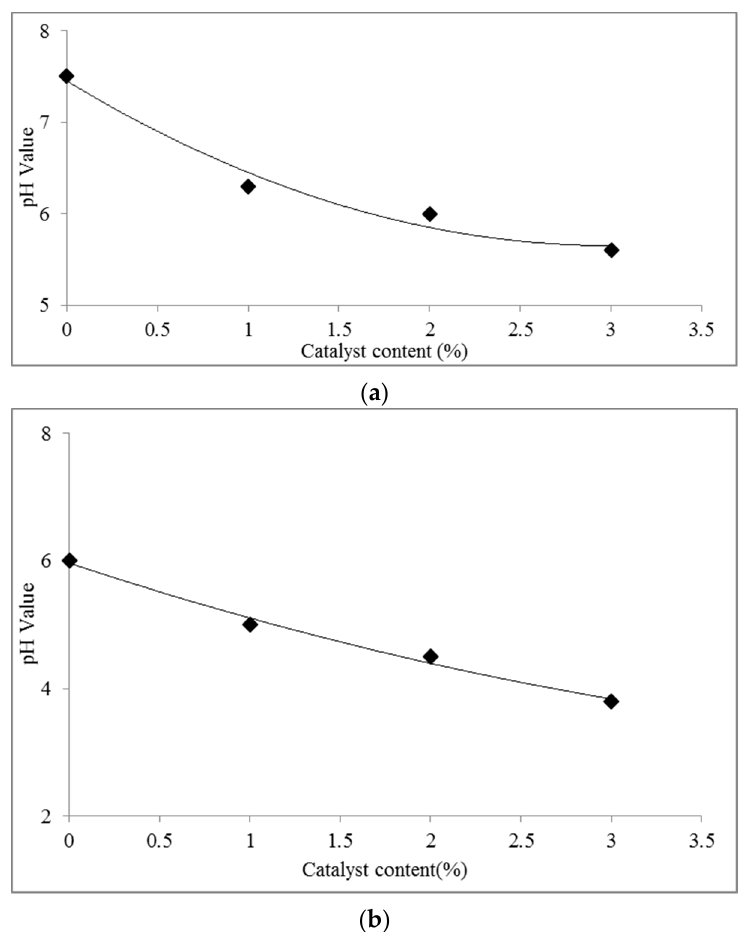
Figure 2. pH value of the UG resin versus the acidic ionic catalyst content at ( a ) ambient temperature ( b ) hot temperature.